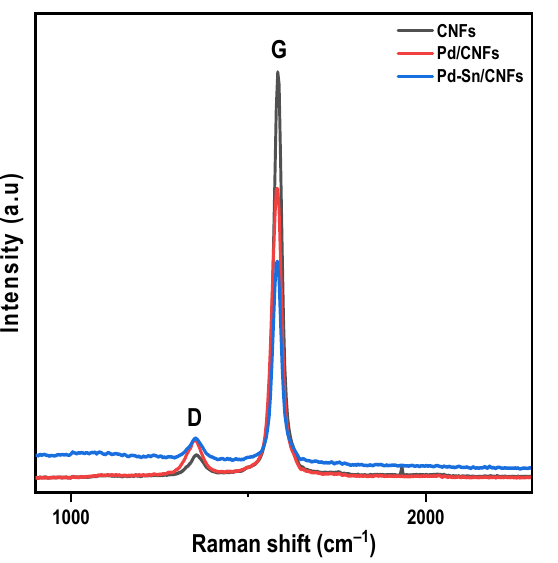
Figure 5. Raman spectrum of carbon nanofibers (CNFs) support, Pd/CNF and Pd-Sn/CNF electro-catalysts.